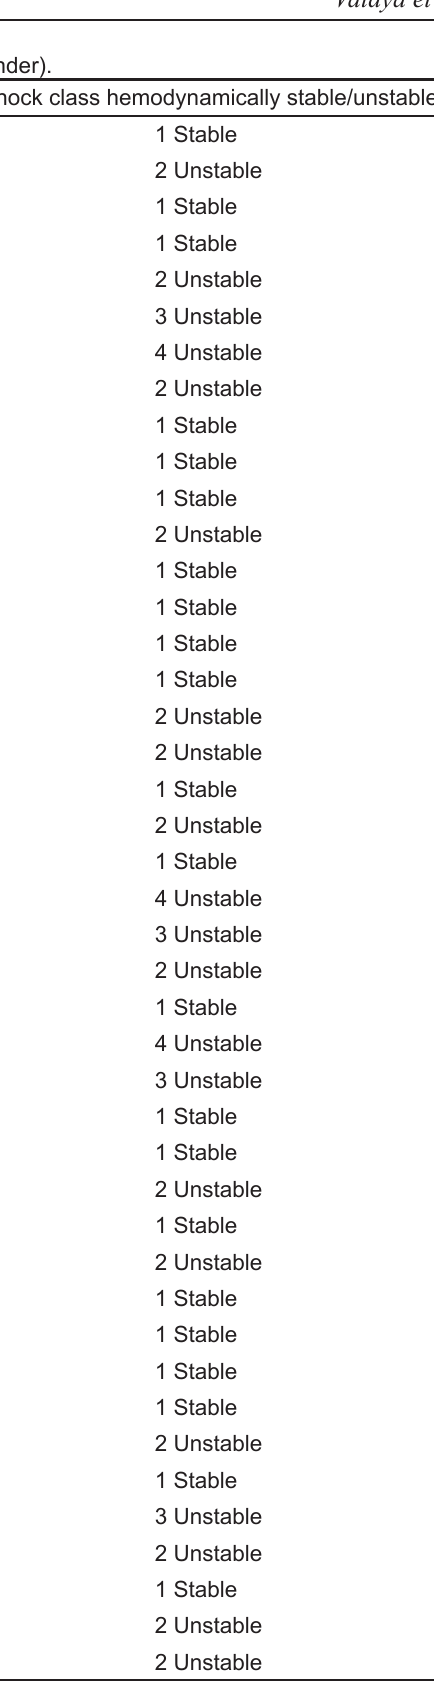
APC, anterior posterior compression; LC, lateral